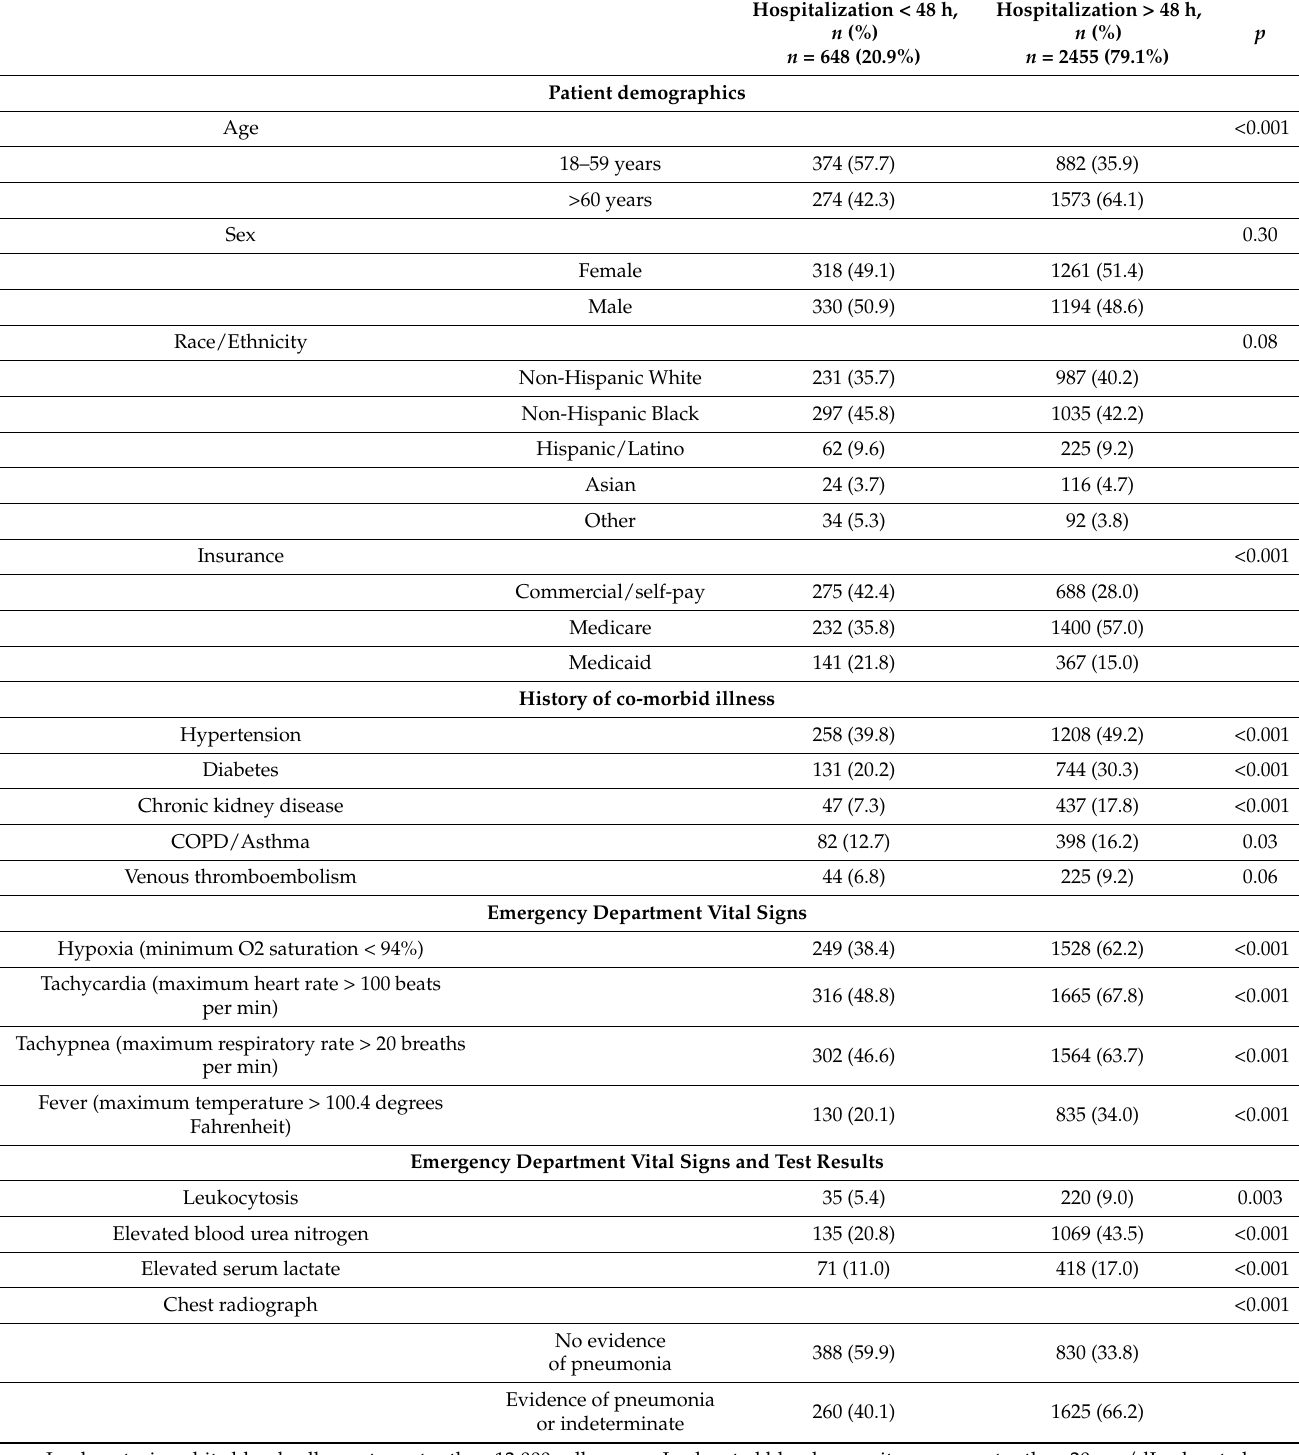
Table 1. Patient characteristics for non-critical care COVID-19 hospitalizations by length-of-stay ( n =